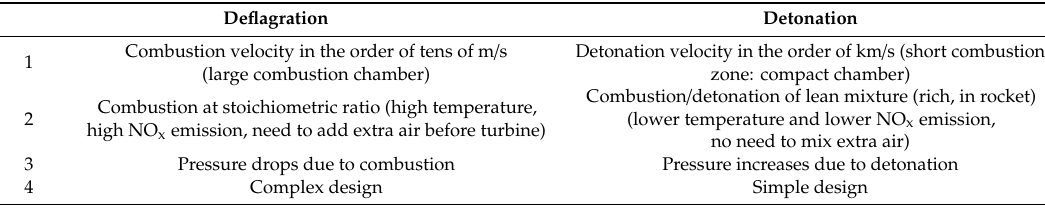
Figure 1. Comparison of theoretical cycles: Bryton (pressure = const.), Humphrey (Volume = const.), Fickett–Jacobs (detonation) for stoichiometric hydrogen—air mixture. Table 2. Comparison of deflagrative versus detonative combustion [18]. Reprint with permission [4915841234612]; Copyright 2012, Elsevier